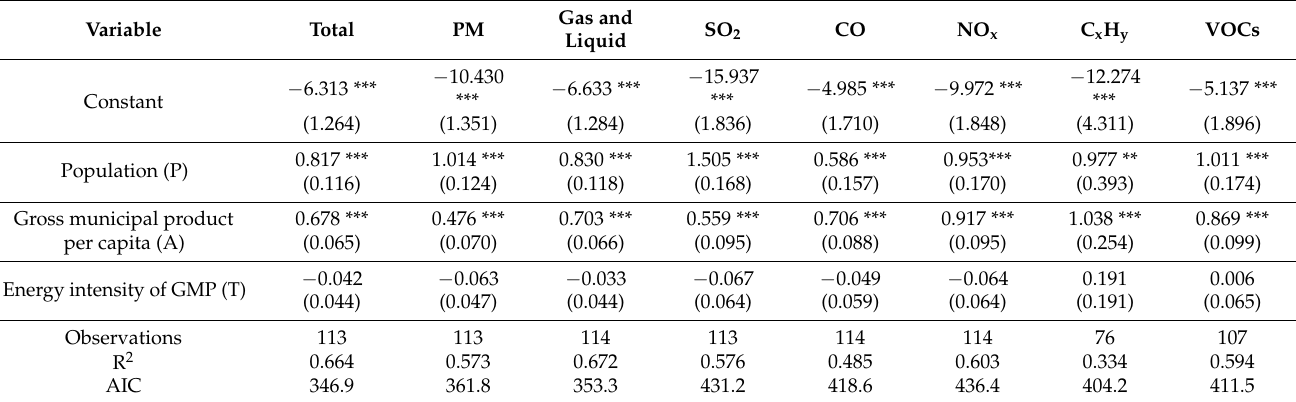
Table 4. Estimates of STIRPAT regression models. All the dependent variables and covariates are in natural logarithms. Calculated by the authors using R with “sandwich” and “stargazer” packages